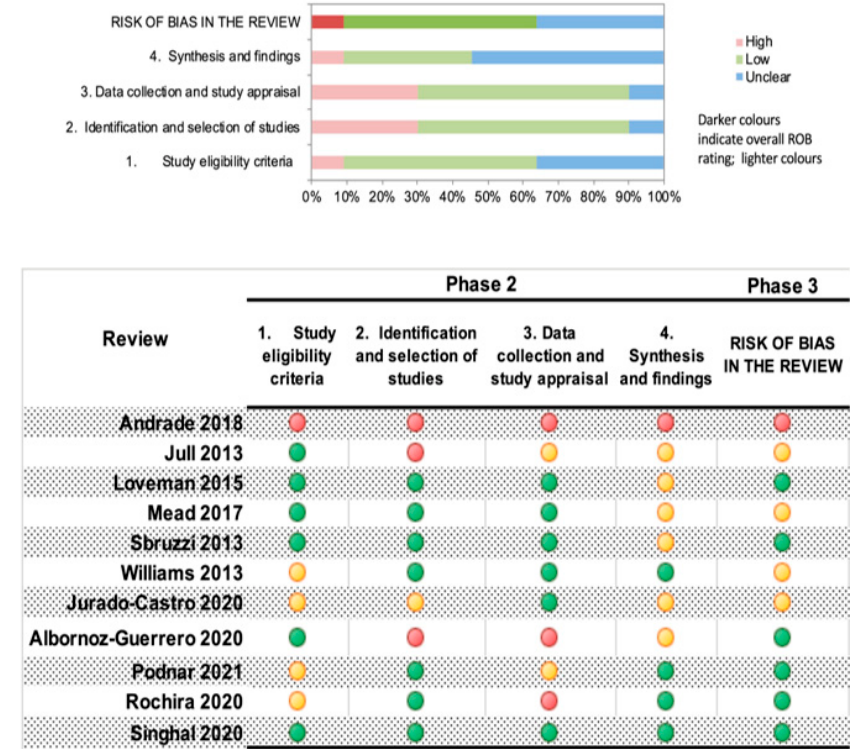
Figure 2. Summary and graph of risk of bias assessment, assessed with ROBIS Tool.